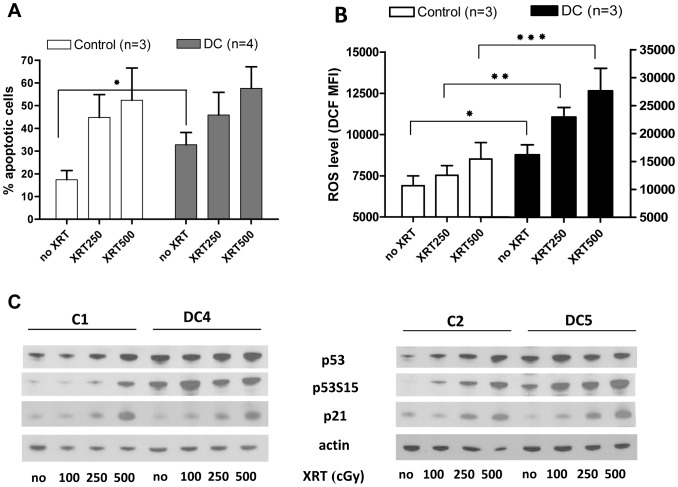
Irradiation-induced levels of apoptosis, ROS and DDR markers in DC lymphocytes.Control and DC cells were subjected to increasing doses of irradiation (0–500 cGy)and 24 hours later assayed for the percentage of apoptotic cells (A) and level of ROS (B). Statistically significant differences were noted between DC and matched controls (*p<0.02, **p<0.003, ***p<0.01) and non-irradiated and irradiated DC (p<0.05). (C) DDR protein expression, including p53, p53S15 and p21 were assessed by Western blotting, and representative blots of five separate experiments are shown.